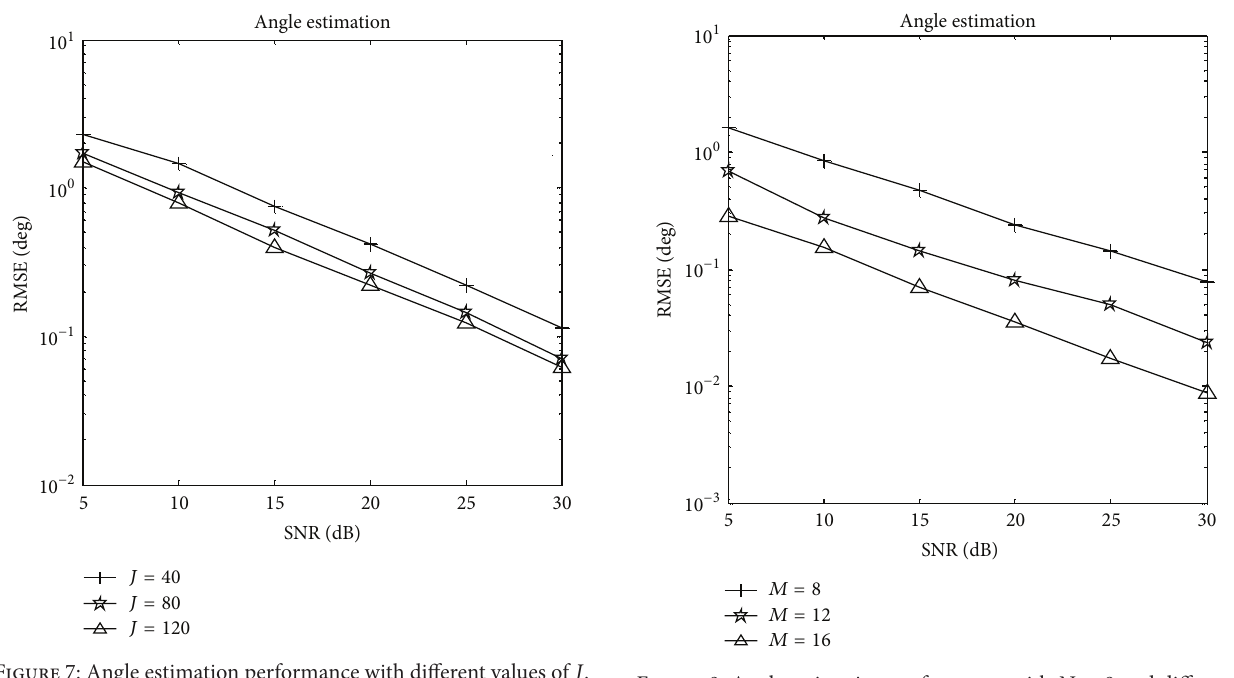
Figure 9: Angle estimation performance with 𝑁 = 8 and different values of 𝑀